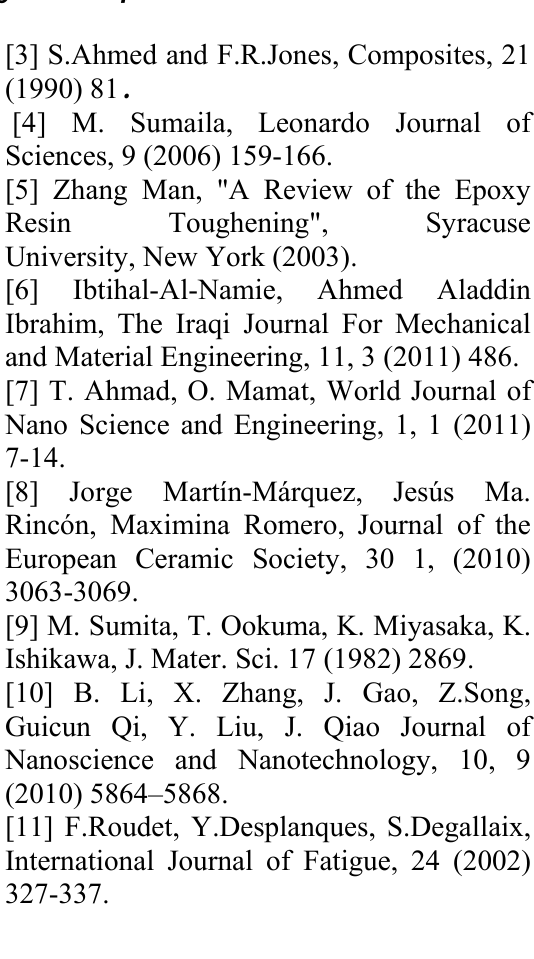
Fig. 7: AFM micrograph shows uniformity and a three-dimensional surface profile of 0.03 SiO nanospheres in the epoxy